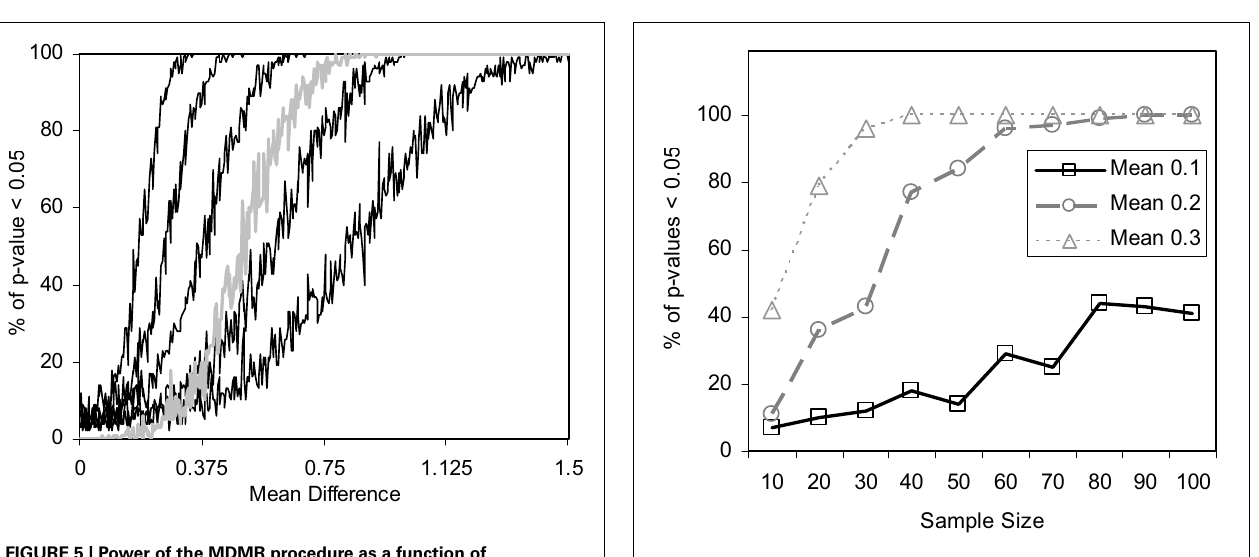
FIGURE 6 | Power of the MDMR procedure as a function of increasing sample size. Half of the samples for each sample size were assigned to a control (coded as 0) and half to an experimental group (coded as 1). For each sample 100 random variables were generated following a normal distribution with a mean of 0 and a variance of 1 for the control group and an assigned mean difference of 0.1, 0.2, or 0.3 and a variance of 1 for the experimental group.